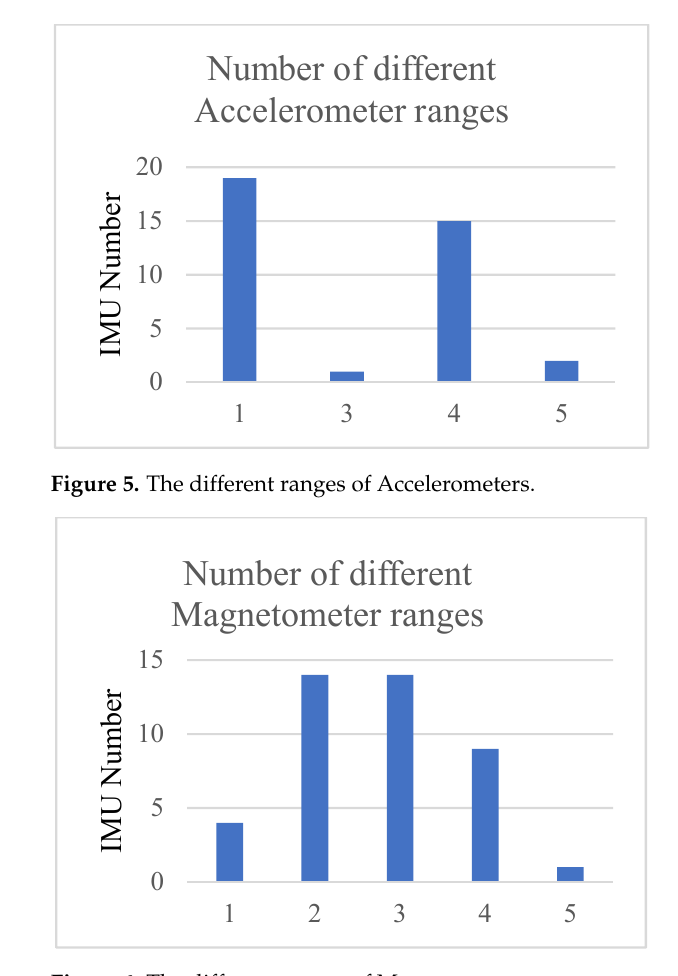
Figure 4. The different ranges of Gyroscopes.